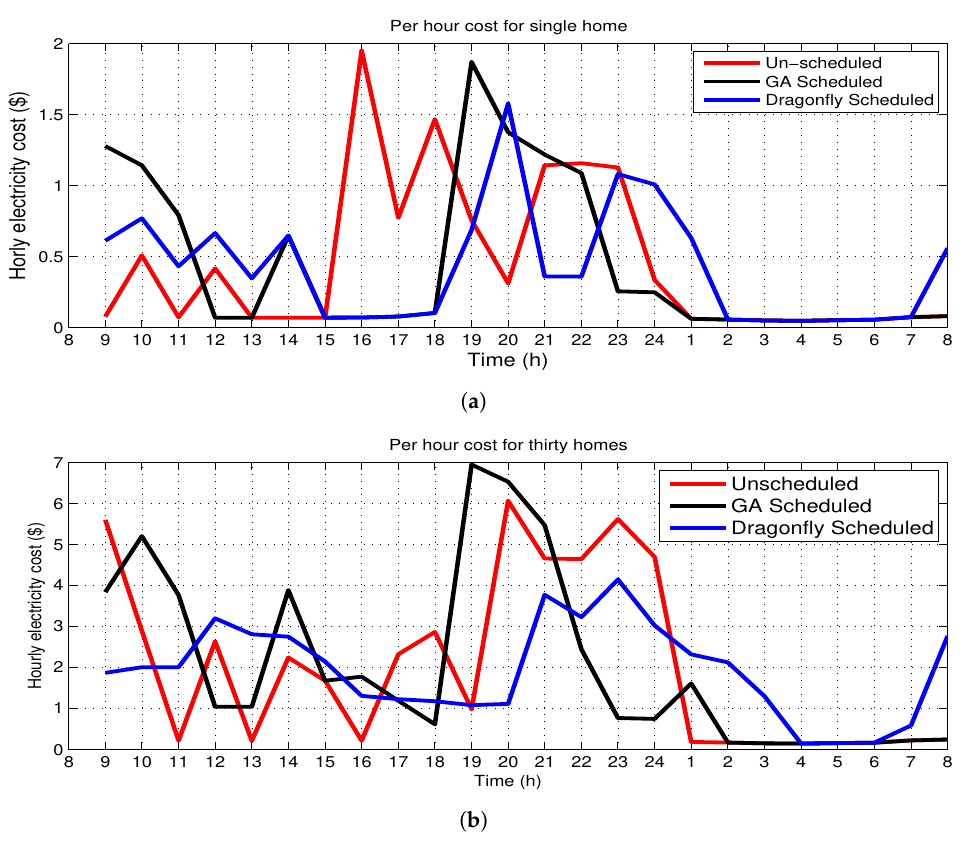
Figure 6. Hourly cost for un-scheduled and GA and DA scheduled ( a ) single home; ( b ) 30